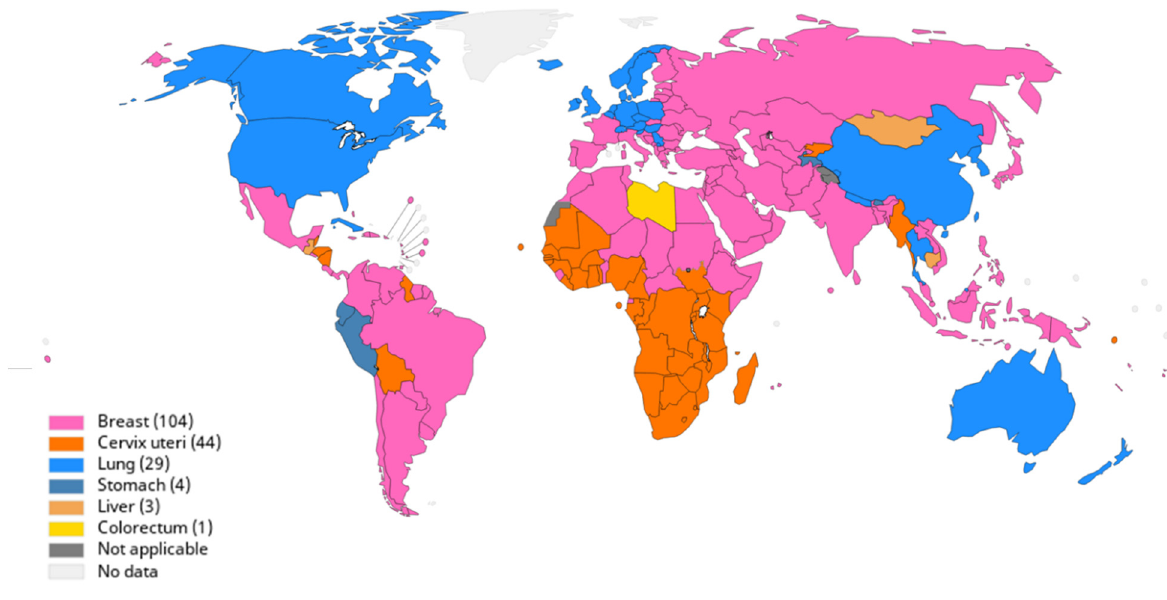
Figure 1. Global cancer mortality. The age standardised rates (ASRs) of various leading cancers worldwide in 2018. Cervical cancer is a major burden in most parts of Africa. Reprinted from [2].